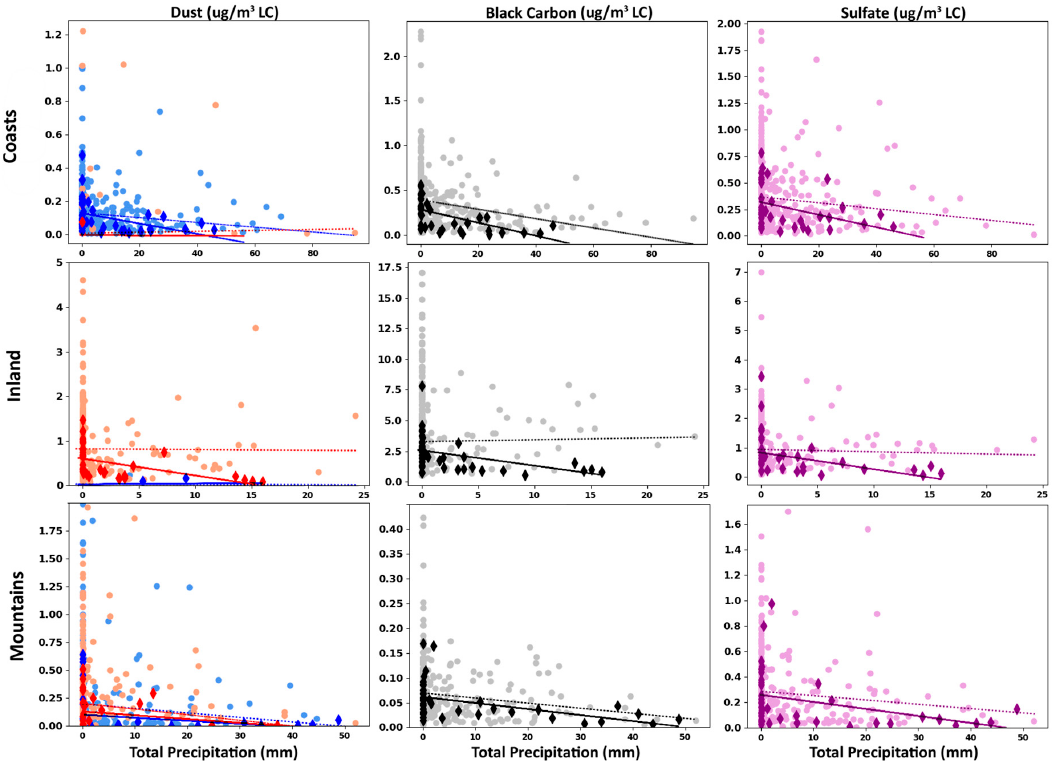
Figure 8. R-value correlations between dust (Asian: Blue, non-Asian: Red), BC, and SO 4 against precipitation. The sites shown are Redwood, Fresno, and Lassen Volcanic to represent coasts, inlands, and mountains, respectively. Climatological data (2007–2016) is represented in the lighter colored circles, while the 2017 data is represented by the darker diamonds.